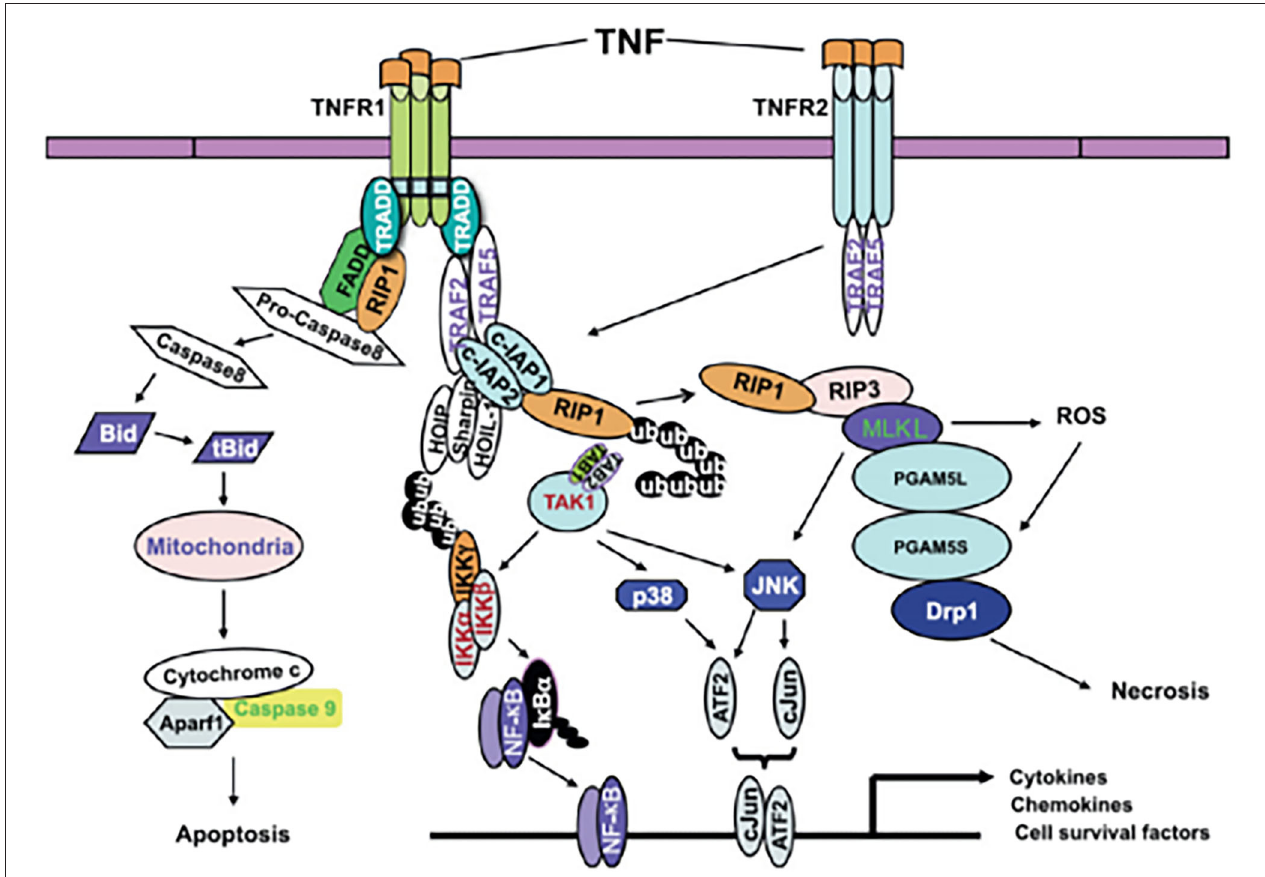
FIGURE 6 | A model of TNF- α signaling in inflammation, apoptosis and necrosis (23).